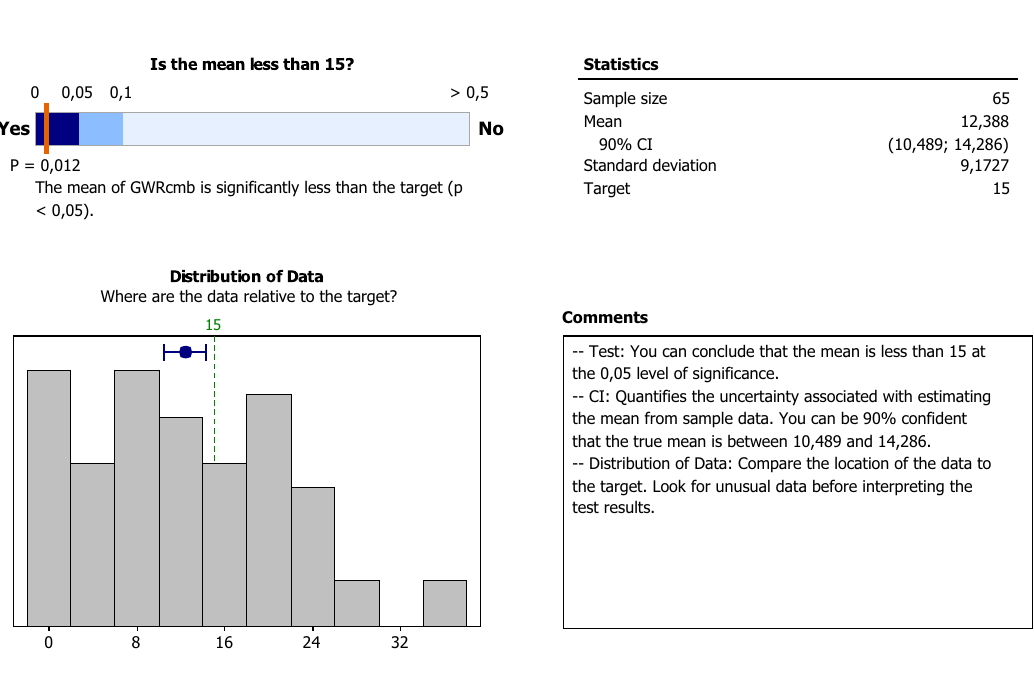
Fig. 7 Sample t test for the mean of